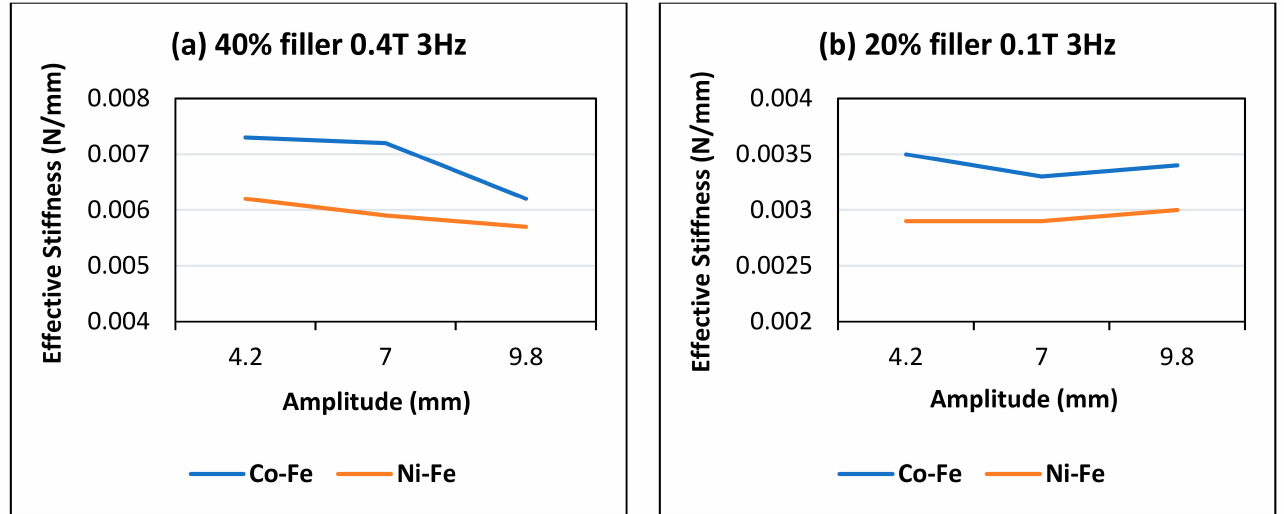
Figure 8. Comparison of amplitude and effective stiffness trends at ( a ) 40% filler and 0.4 T flux ( b ) 20% filler and 0.1